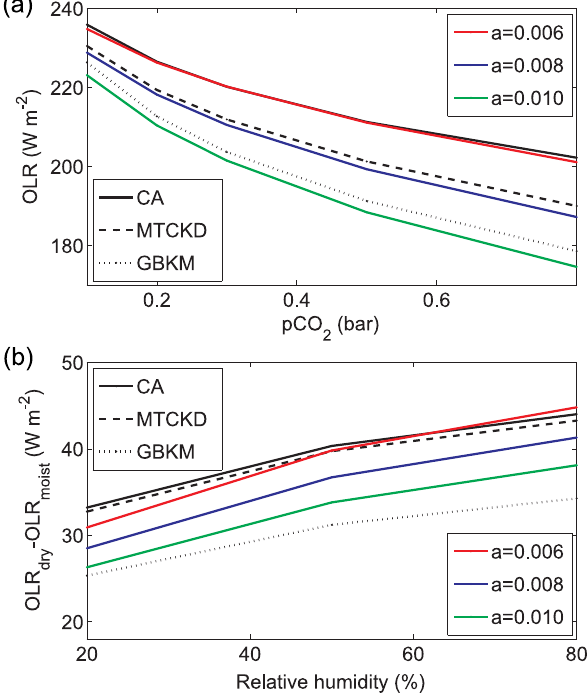
Fig. 2: Tuning of the longwave radiation scheme to approximate the MTCKD parameterisation for high partial pressures of CO 2 . Black lines show the outgoing longwave radiation under fixed boundary conditions for three different parameterisations as in Halevy et al. (2009). Coloured lines show the outgoing longwave radiation under the same boundary conditions as in our model simulations for different values of the parameter a . Panel (a) displays the dependency on CO 2 partial pressure in a dry atmosphere, while panel (b) shows the effect of water vapour on an atmosphere with p CO 2 = 0.5 bar in terms of OLR. Note the different scales of the two panels. consists of Hadley, Ferrel and polar cell in each hemisphere. When simulating the present-day climate, the cell boundary positions are in a first step fixed to latitudes of 0 ◦ , 30 ◦ and 60 ◦ , while the actual position at each point of time is in a second step adjusted according to the position of the thermal equator (Petoukhov et al., 2000). The strength of each cell is parameterised in terms of the mean temperature T i within the cell and the temperature contrast ∆ T i between its boundaries ( ϕ i (cid:0) 1 and ϕ i ):